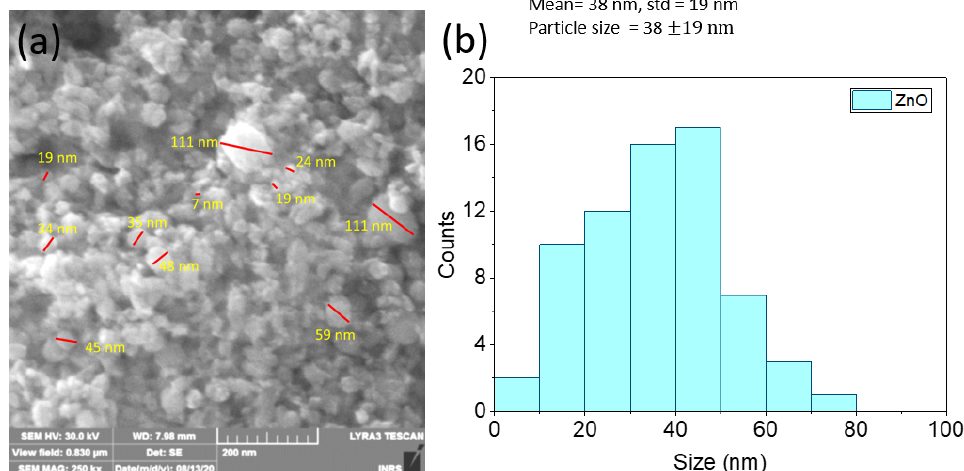
Figure 2. ( a ) SEM image and ( b ) particle size distribution of the ZnO nanoparticles grown by PLAL.